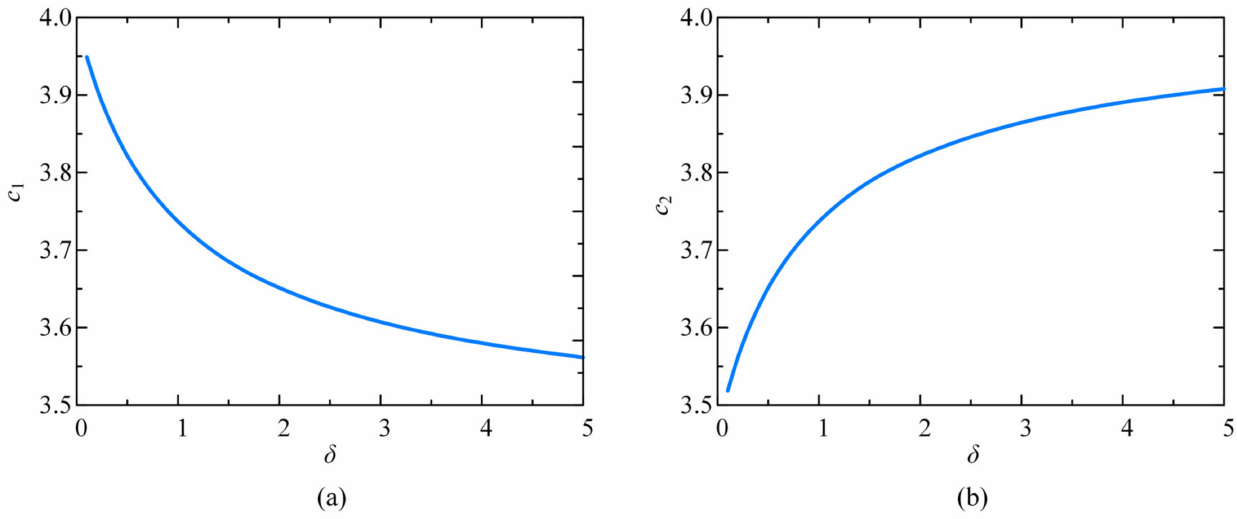
Figure 4. Variation in c 1 and c 2 with beam-to-column line stiffness ratio. (( a ) Relationship between c 1 and δ ; ( b ) Relationship between c 2 and δ